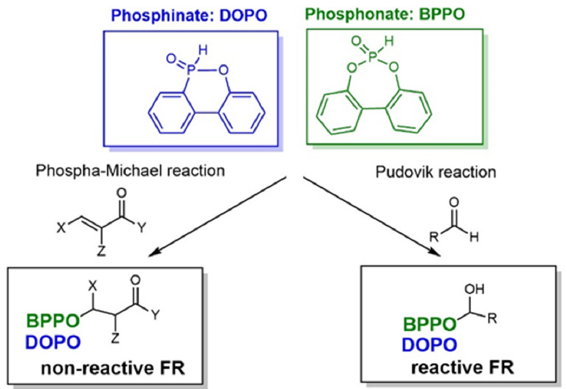
Figure 1. Research concept for the development of phosphorus-containing halogen-free FRs for PIR foams.